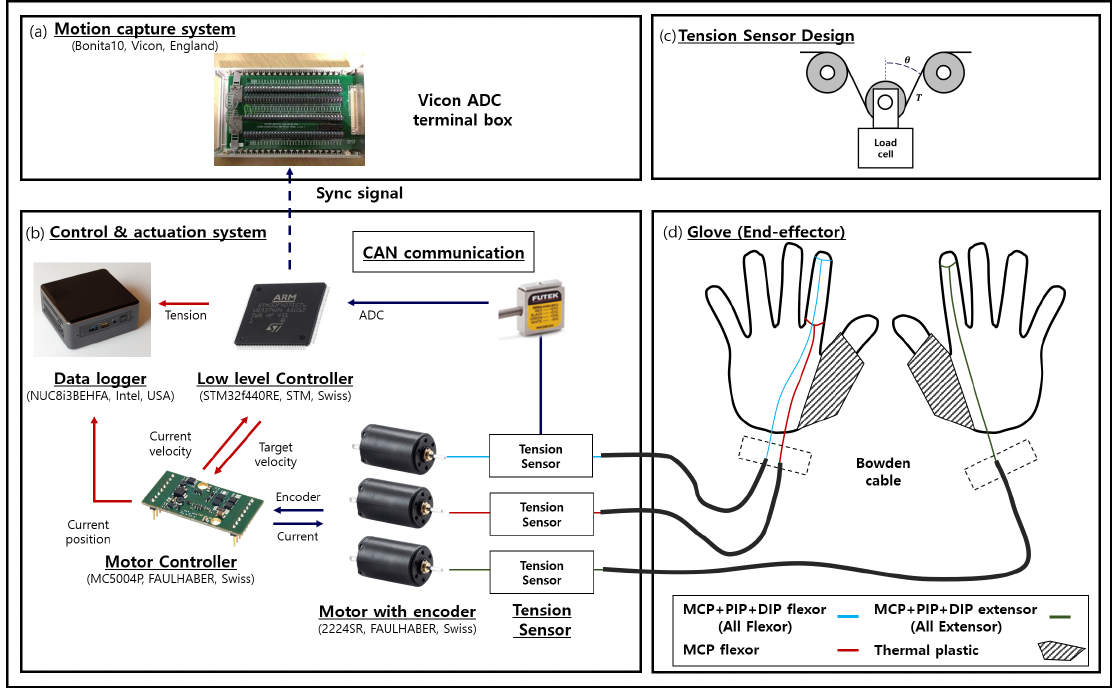
Figure 1. Schematic view of the Exo-Index system; ( a ) shows an external device for synchronizing load cell data measured in the MCU and posture data measured by the Vicon; ( b ) shows overall control and actuation system for the robot; ( c ) shows how the tension sensor is designed using loadcell; ( d ) provides a brief look at how the three tendons of the actuator are connected to the glove.